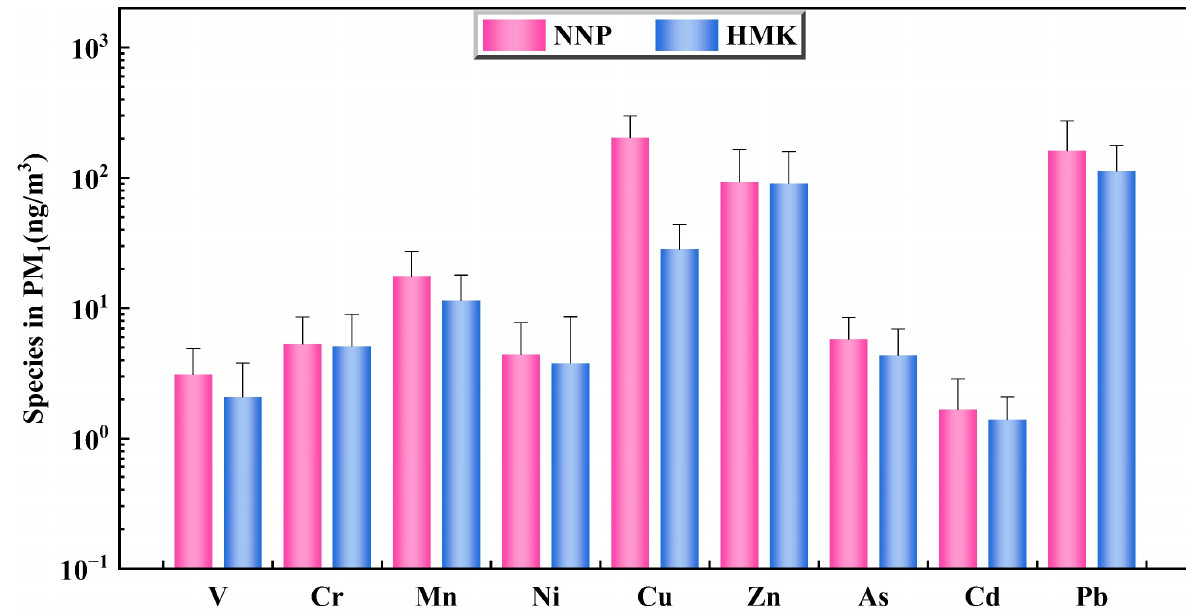
Figure 7. Annual average concentrations of PTEs in PM 1 .